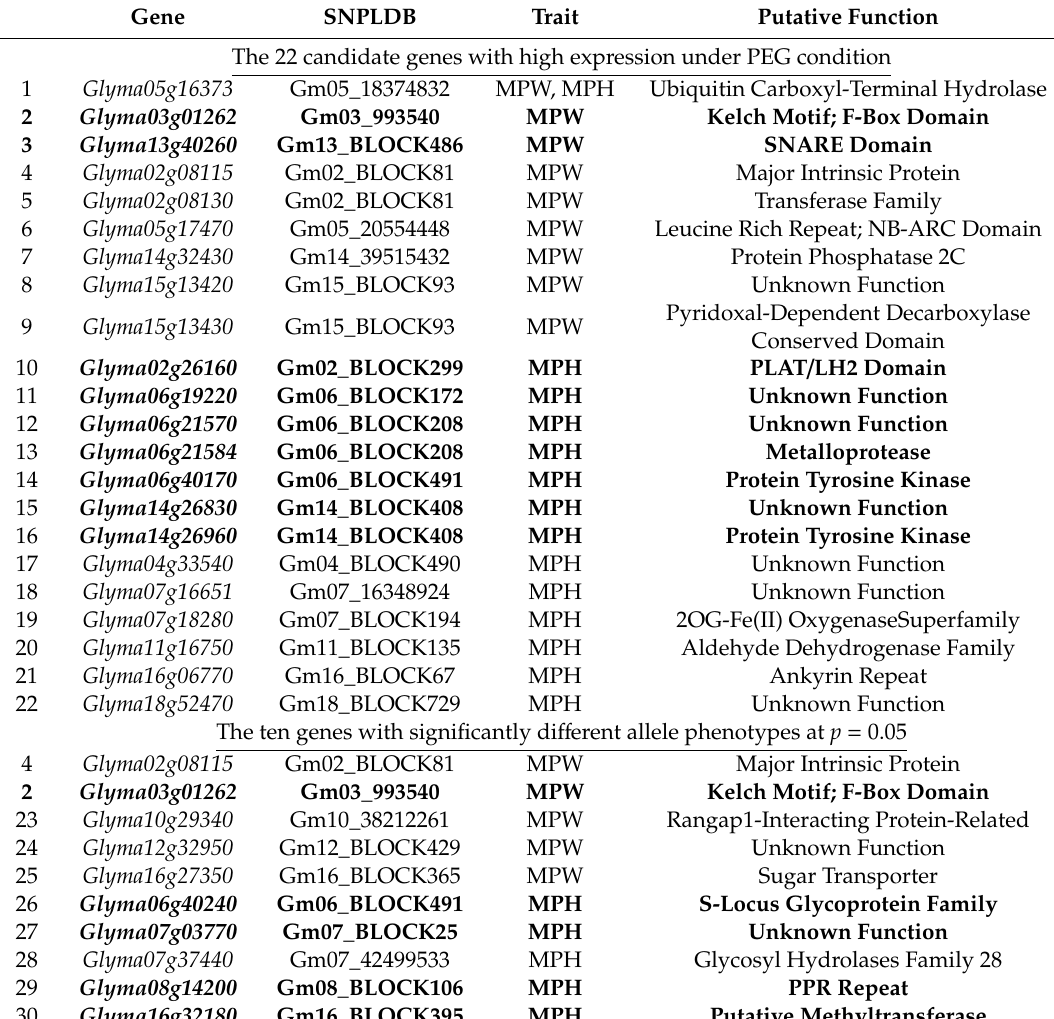
Table 8. The 30 most likely candidate DT genes identified from high expressions in qRT-PCR or significant di ff erence among candidate gene-alleles in ANOVA (two ones identified from both criteria). Gene SNPLDB Trait Putative Function The 22 candidate genes with high expression under PEG condition